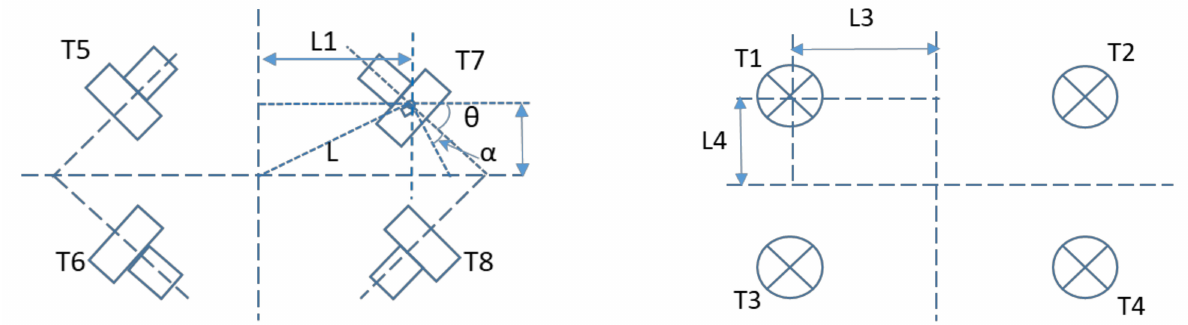
Figure 8. The vectoral configuration of thrusters of